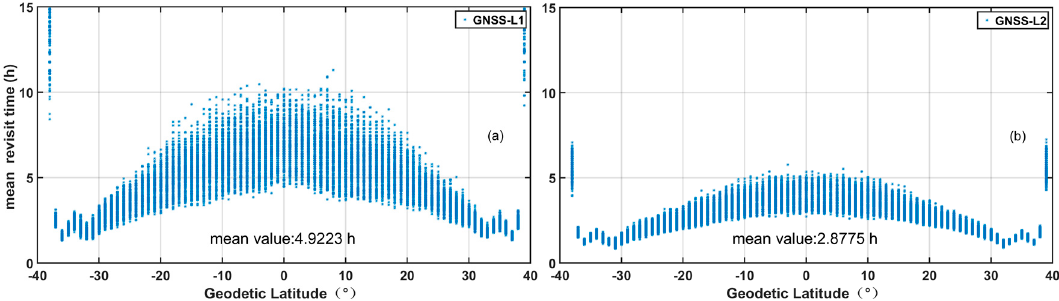
Figure 12. Mean revisit times in the bins for the four-system GNSS-R at different latitudes during a single cycle at the GPS L1 ( a ) and L2 ( b ) frequencies.